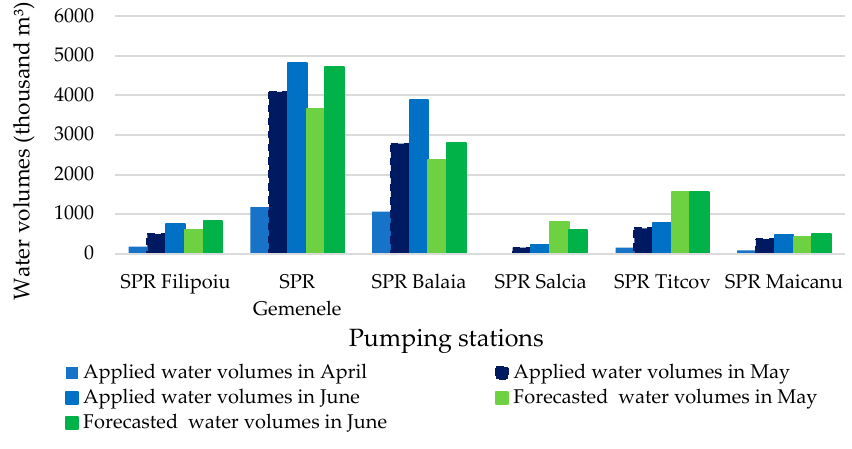
Figure 14. Forecasted and applied water volumes in 2018 at the scale of main pumping stations (SPR) located in the IMB Irrigation District.